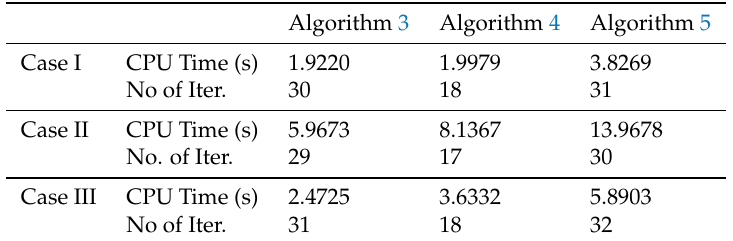
Table 2. Numerical results for Example